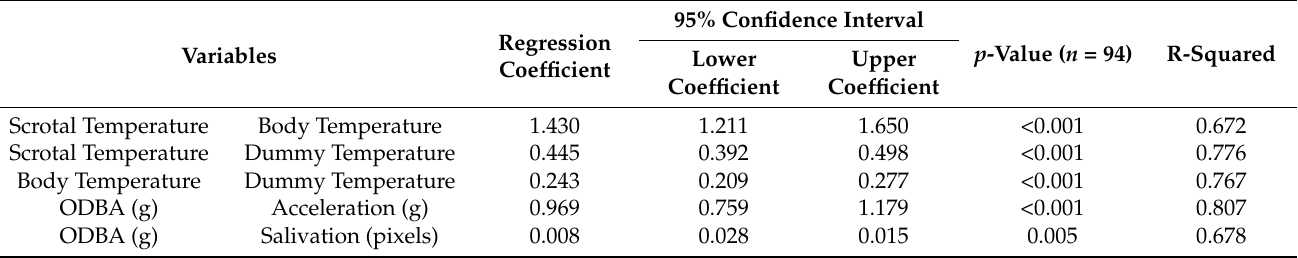
Table 3. Correlations that were significant at p < 0.05, between salivation, accelerometer sensor and thermal